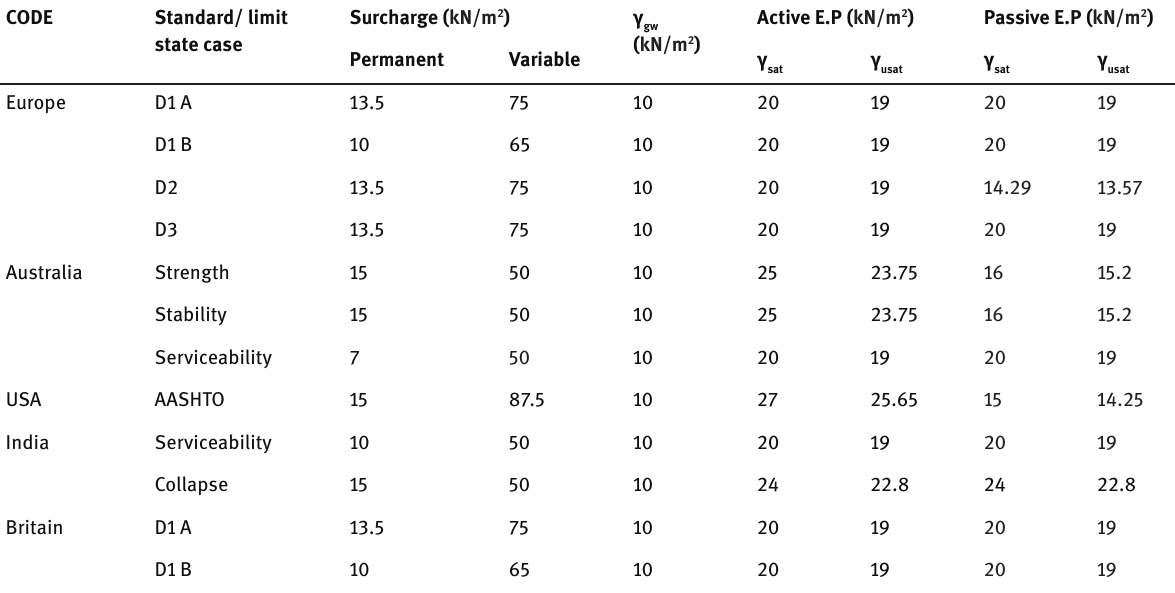
Table 4: Factored values applied for calculating loads and resistances.